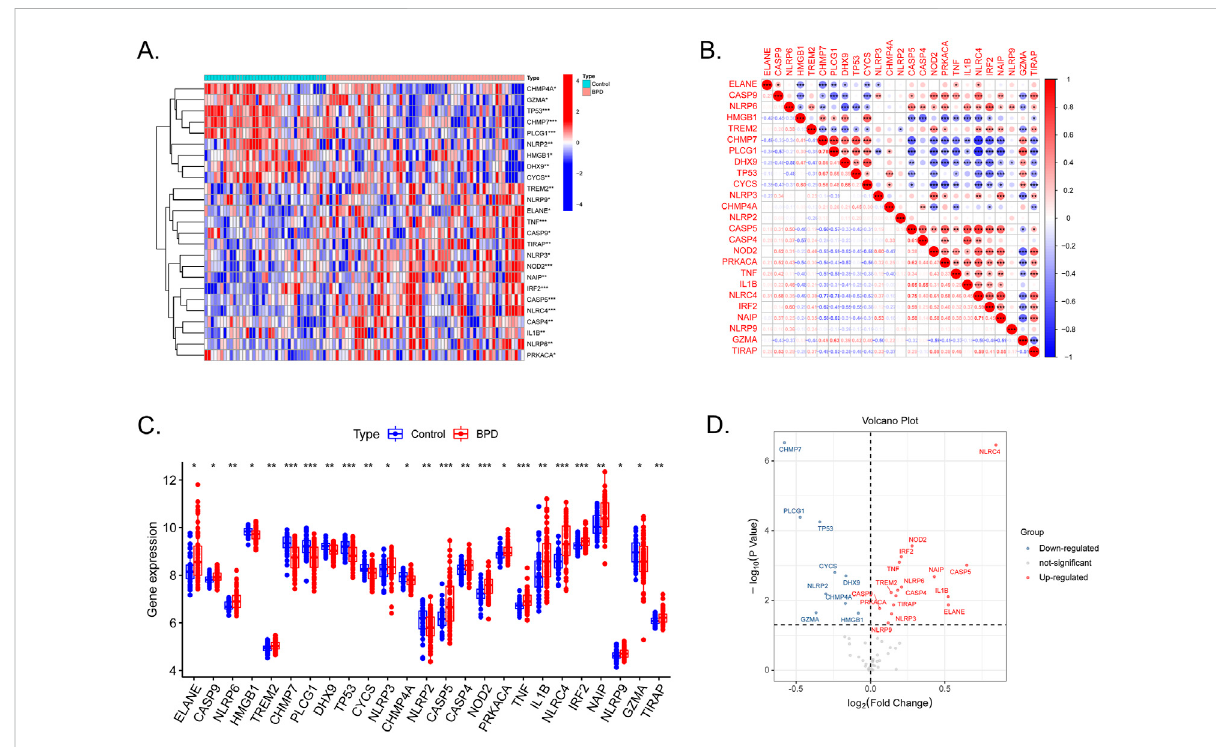
FIGURE 1 Expression levels of DE-PRGs in BPD. (A) Heatmap shows expression patterns of DE-PRGs. (B) Correlations between these genes and BPD. (C) The expression of the 25 DE-PRGs in BPD and control samples. (D) The volcano plot with visualized